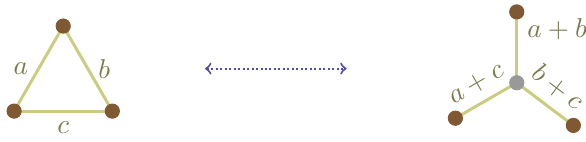
Figure 17. The new entropy-preserving graph operation ∆ - Y . Vertices are color-coded as in fig.